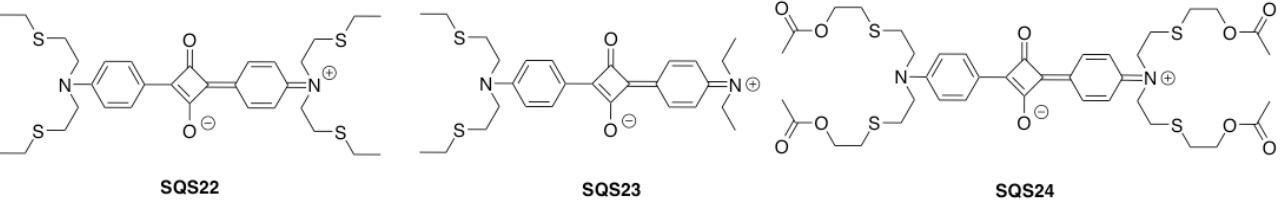
Figure 4. Structures of thio-containing sensors SQS22 [80], SQS23 [81], and SQS24 [82].